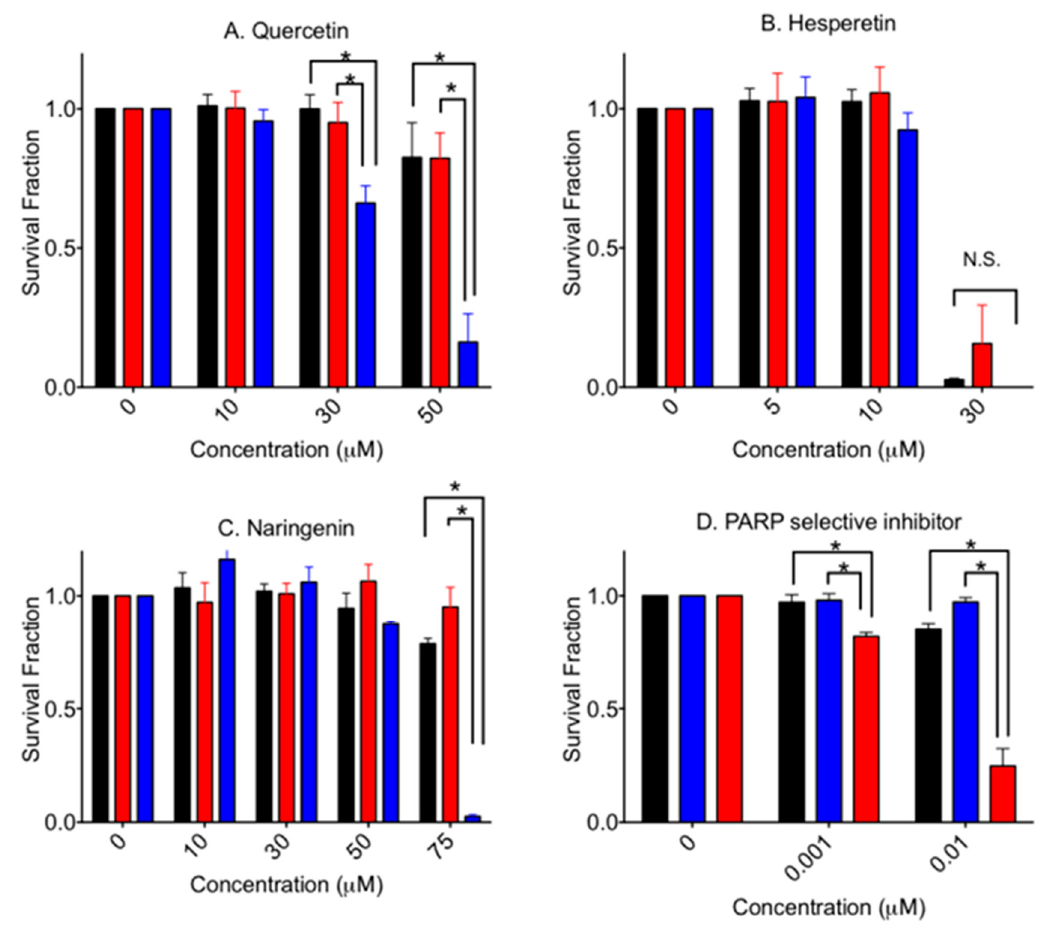
Figure 3. Cytotoxicity by aglycone form of flavonoids and PARP selective inhibitor. ( A ) quercetin, ( B ) hesperetin, ( C ) Naringenin, and ( D ) olaparib. Black bars indicate V79 cells. Red bars indicate V-C8 gene-corrected cells. Blue bars indicate V-C8 BRCA2-deficient cell. Mean values and standard error of the means from at least three independent experiments are plotted. * Indicates statistically significant differences ( p < 0.05). N.S. means not significant differences.